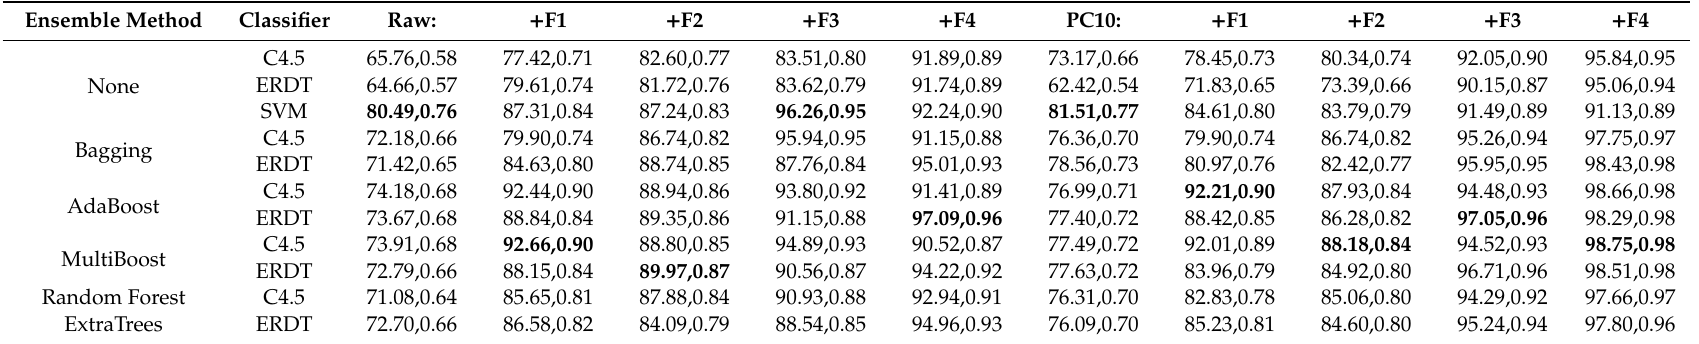
Table 1. The best OA and kappa statistics for considered classifiers using MPs, MPPR, OMPs and OMPsM features from PCA-transformed features of Pavia University